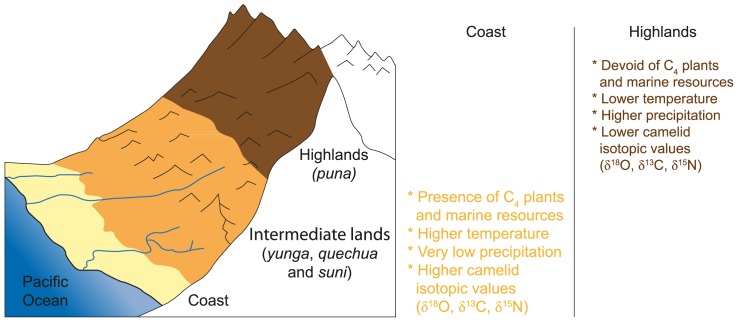
Central Andes ecozones and altitudinal environmental variations.Cross-section of the western slopes of the Central Andes with the main ecological zones considered in the study with expected trends in variations in environmental conditions and δ13C, δ15N and δ18O measured in domestic camelid tissues.